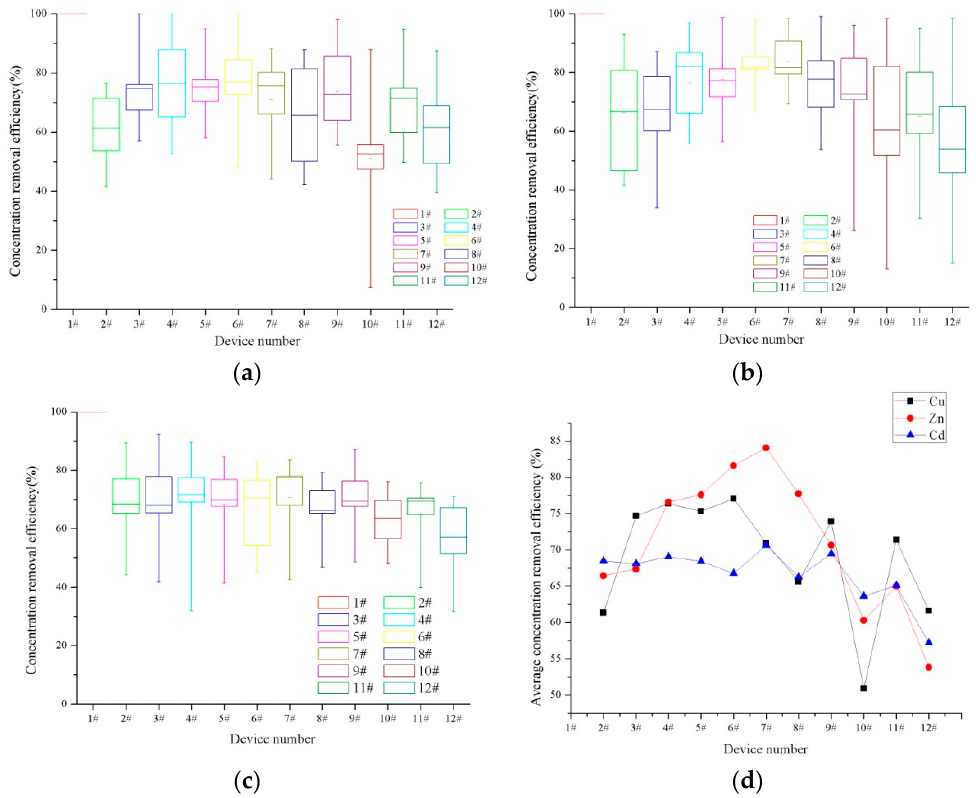
Figure 2. Concentration removal efficiency in different media combinations; ( a ) Cu; ( b ) Zn; ( c ) Cd; ( d ) average concentration removal efficiency.